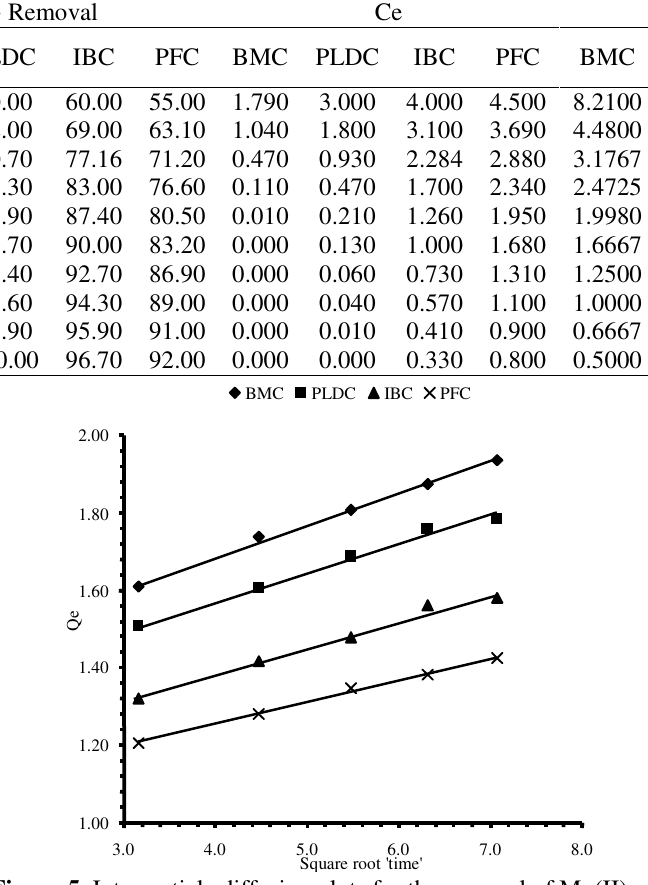
Figure 5 . Intraparticle diffusion plots for the removal of